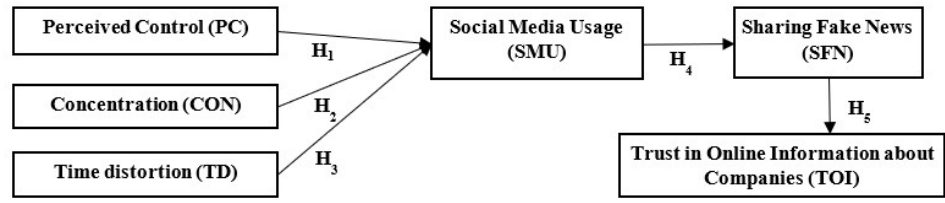
Figure 1. Conceptual model. Source: own development.